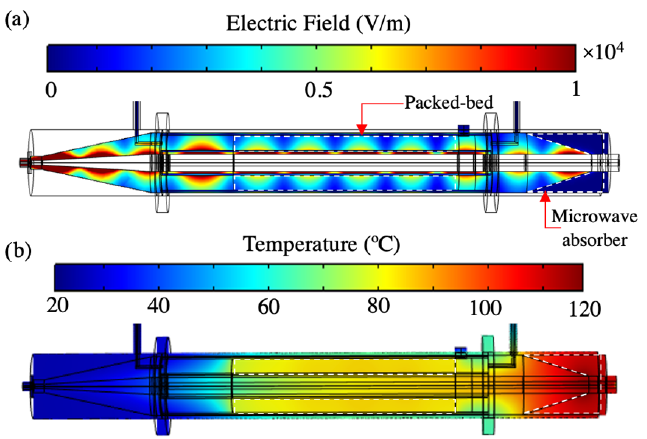
Figure 3. ( a ) Temperature and ( b ) Electric field distribution after 120 min in the reactor loaded with crushed α -SiC foam under 60 W microwave power input.